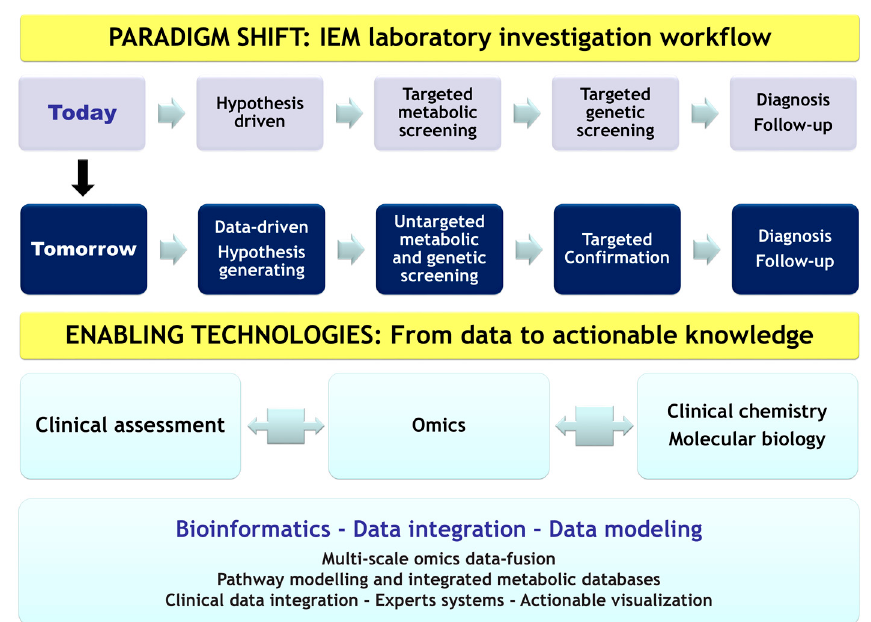
Figure 4. Paradigm shift in Inborn Errors of Metabolism diagnosis workflow. The change in molecular information recovery in laboratory investigation workflow is driven by advancing analytical technologies and bioinformatics systems for a more effective medical practice using an integrative computational framework. IEM: Inborn Errors of Metabolism.